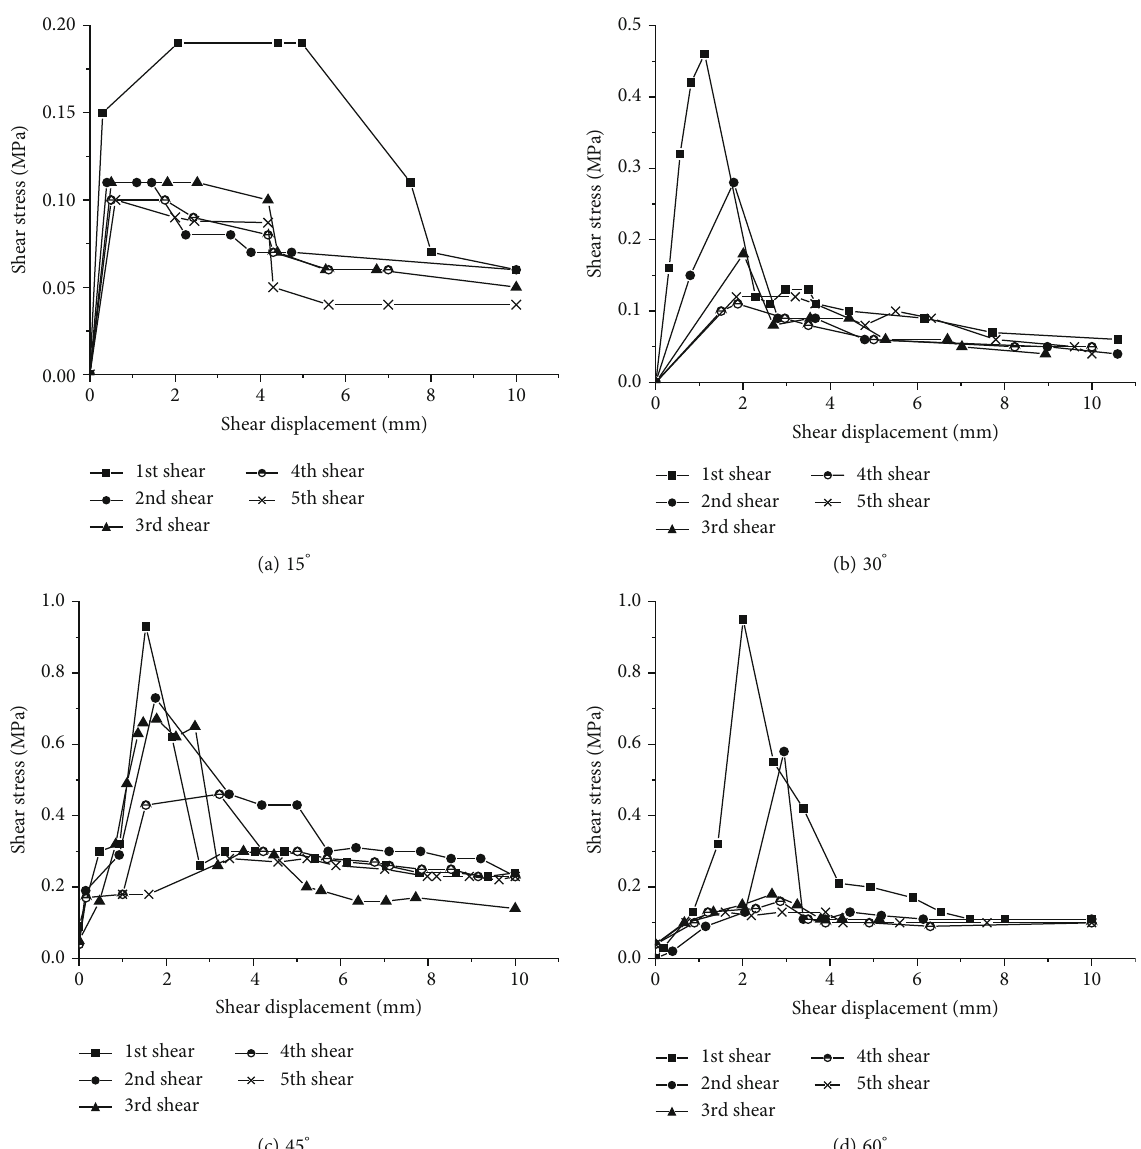
Figure 4: Displacement – stress curve of structural planes with di ff erent undulating angles under cyclic shear A fi tting curve can be obtained after a regression fi tting of the experimental results in Figure 6. The correlation coef- fi cient of fi tting is 0.97221, which means that the fi tting curve is in good correlation with experiment results. The fi t- ting result shows that Q 0 = 0 : 03867 and c = 0 : 05619 ; that is,